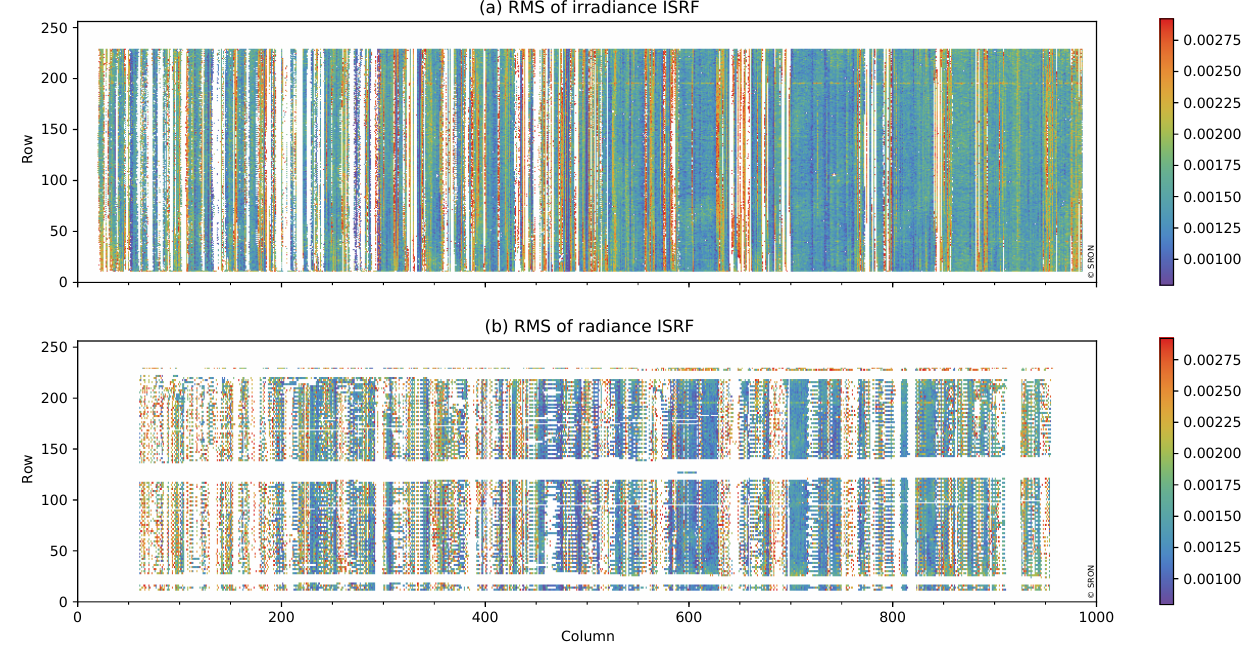
Figure 7. Fit quality of the local ISRF using the (a) irradiance port and (b) radiance port. No measurements are performed in the white edges. (a) White vertical stripes are due to saturation in the measurements, and red vertical stripes are due to nearby saturation or laser instabilities. (b) White areas are due to partly illuminated rows.